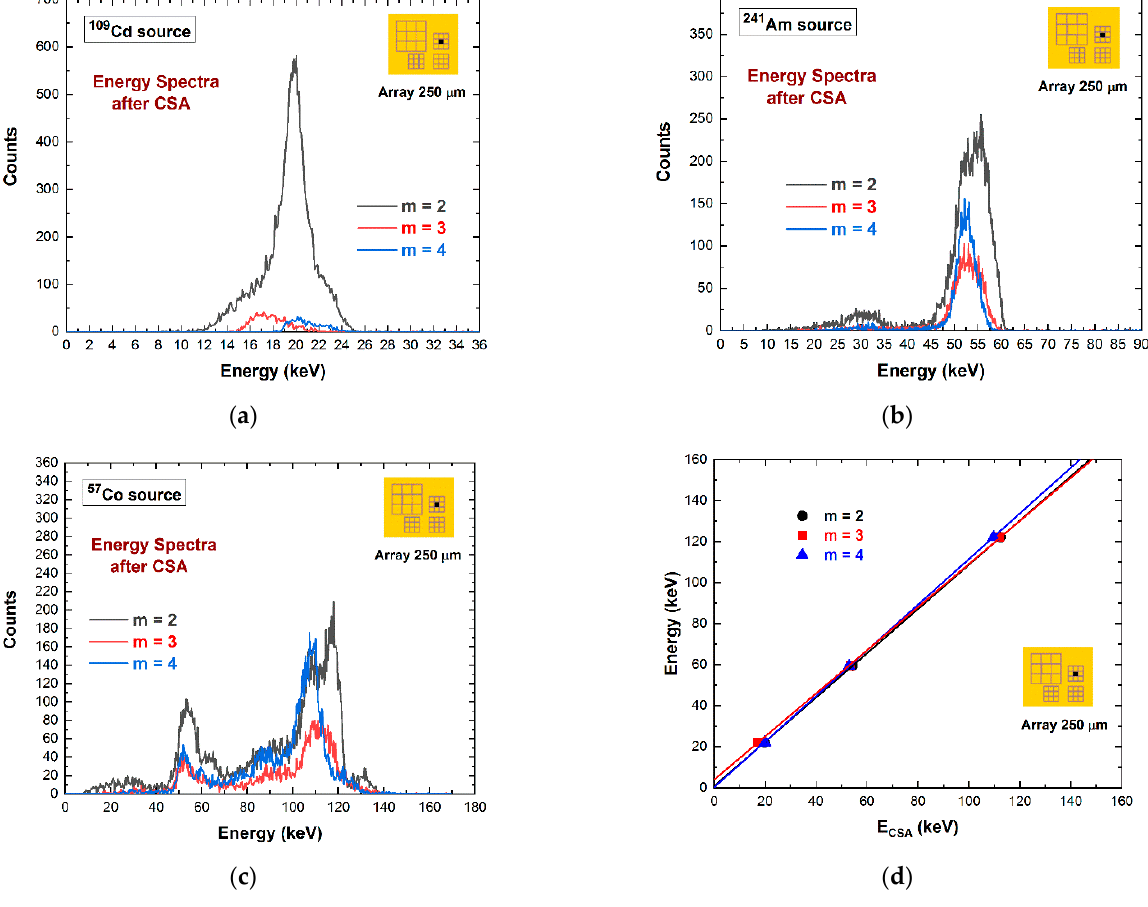
Figure 10. ( a ) 109 Cd, ( b ) 241 Am, and ( c ) 57 Co spectra after CSA at various multiplicities. ( d ) The linearity of E CSA with the true photon energy opens up to a correction of charge losses after CSA through a simple energy re-calibration.